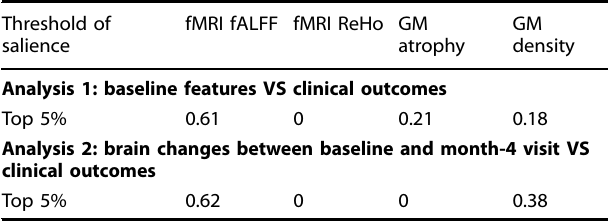
Table 2. Mean contributions of each imaging modality in the signi fi cant latent variables space. Contribution values range from 0 to 1, indicating the fraction of total contribution among other modalities.